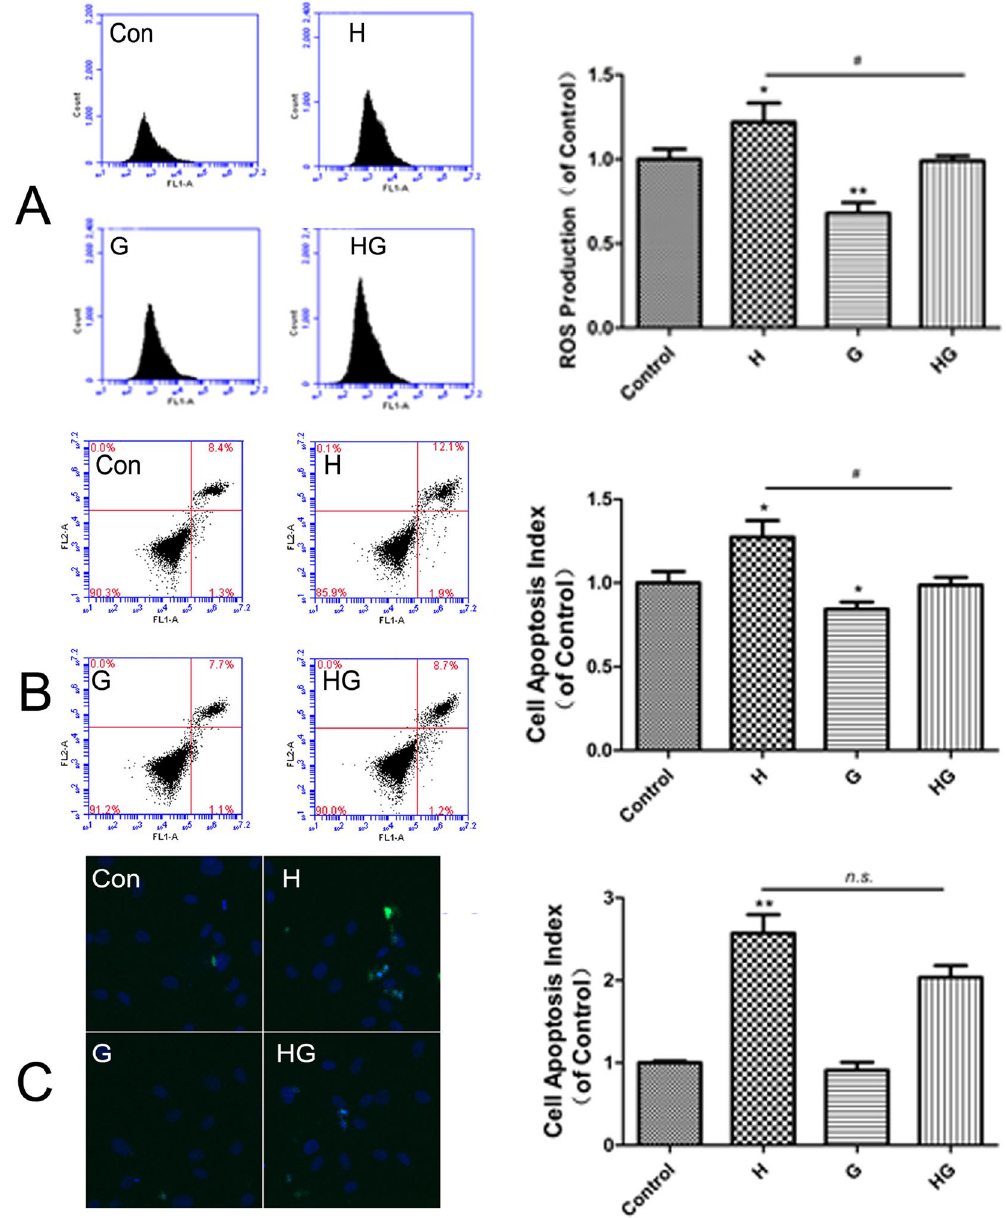
Figure 3. GLP-1 pretreatment attenuated ROS generation and apoptosis in HUVECs induced by 33 mmol/L glucose for 48 h. GLP-1 decreased ROS production in HUVECs induced by high glucose ( A ). GLP-1 decreased the apoptosis rate in HUVECs induced by high glucose, as detected using an Annexin V-PI assay ( B ). GLP-1 decreased the apoptosis rate in HUVECs induced by high glucose, as detected by TUNEL ( C ). Data are shown as the mean ± SEM, n = 5 independent experiments. * P < 0.05 vs control. # P < 0.05 vs high glucose, ** P < 0.01 vs control. n.s. P > 0.05 vs high